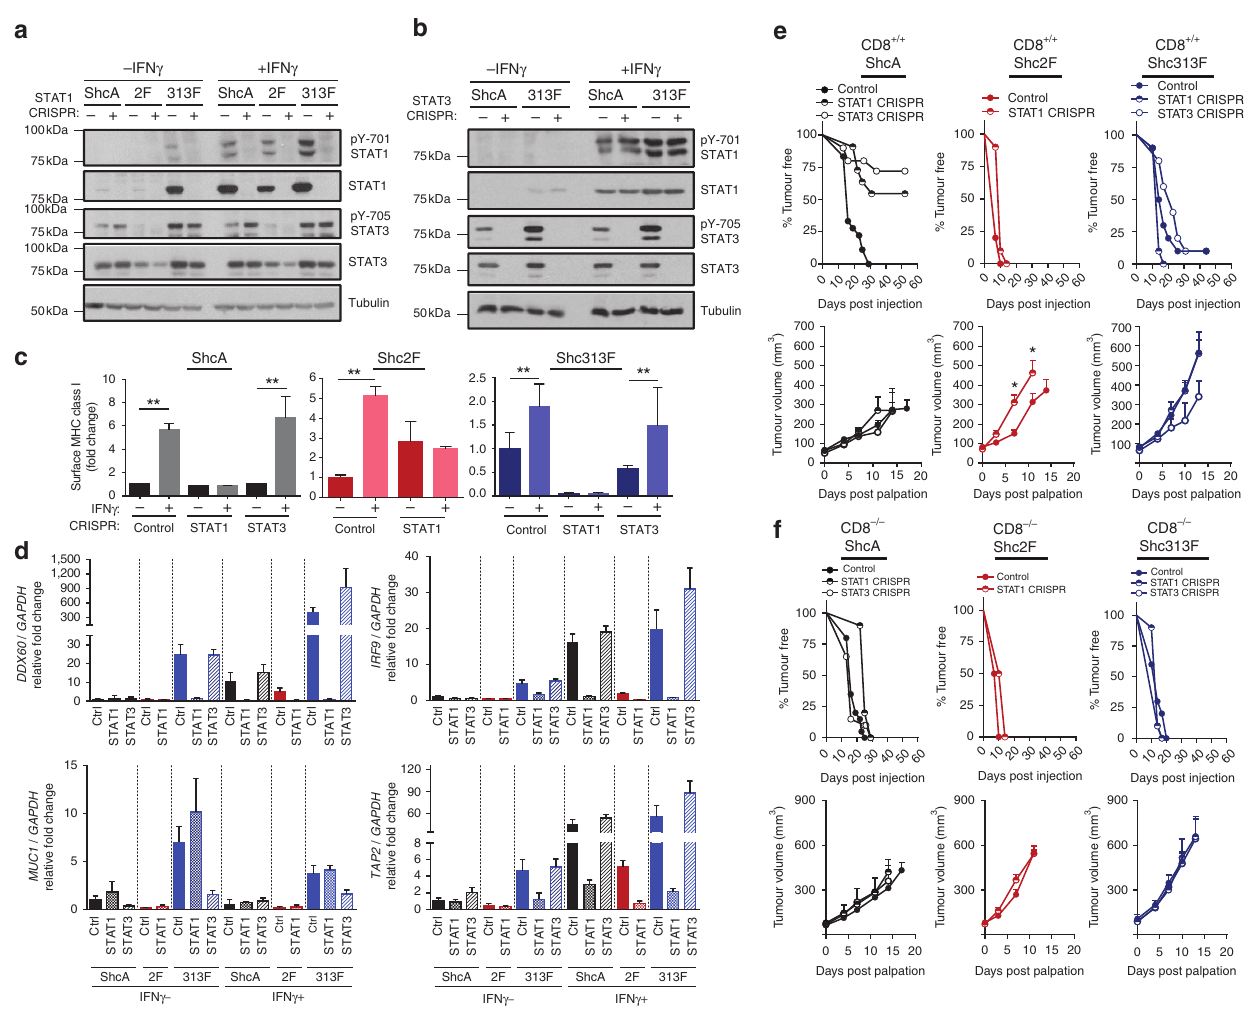
Figure 4 | The STAT3 activation status of mammary tumours dictates whether STAT1 elicits pro- or anti-tumour immune responses. MT/ShcA þ / þ (864), MT/Shc 2F/2F (5372) and MT/Shc 313F/313F (6738) cell lines were stably deleted of ( a ) STAT1 , and ( b ) MT/ShcA þ / þ (864) and MT/Shc 313F/313F (6738) cells were stably deleted of STAT3 by CRISPR/Cas9 gene editing. Total cell lysates from the indicated cell lines were analysed by immunoblotting after 24h of PBS or IFN g (0.2ngml (cid:2) 1 ) treatment. Representative image of three independent experiments is shown. ( c ) Surface MHC class I expression levels in the indicated cell lines as assessed by flow cytometry after 24h IFN g treatment (0.2ngml (cid:2) 1 ) or PBS (control). Data represented as fold change in the geometric mean ± s.d. relative to control cell lines for each genotype ( n ¼ 6, two independent experiments). ( d ) Relative IRF9 , DDX60 , TAP2 and MUC1 mRNA levels, normalized to GAPDH levels in the absence (PBS) or presence (0.2ngml (cid:2) 1 ) of IFN g . The data are shown as the average fold change relative to PBS-treated MT/ShcA þ / þ (Control CRISPR) cells ± s.d. ( n ¼ 5 per group). ( e , f ) Mammary fat pad injection of the indicated cell lines into ( e ) FVB (CD8 þ / þ ) or ( f ) CD8 (cid:2) / (cid:2) mice. Tumour incidence is based on the per cent tumour-free mammary glands over the indicated days post injection. The rate of tumour outgrowth is represented as mean tumour volume (mm 3 ) ± s.e.m. ( n ¼ 10 tumours) (* P o 0.05 and ** P o 0.01; unpaired two-tailed